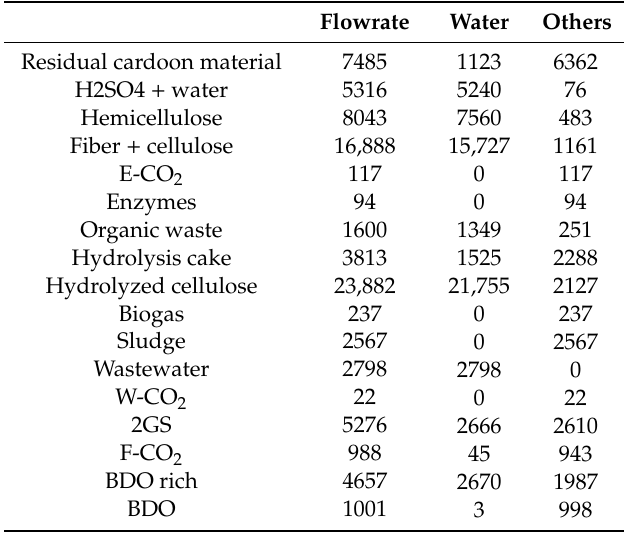
Table 5. Material balances for the main process streams (kg /